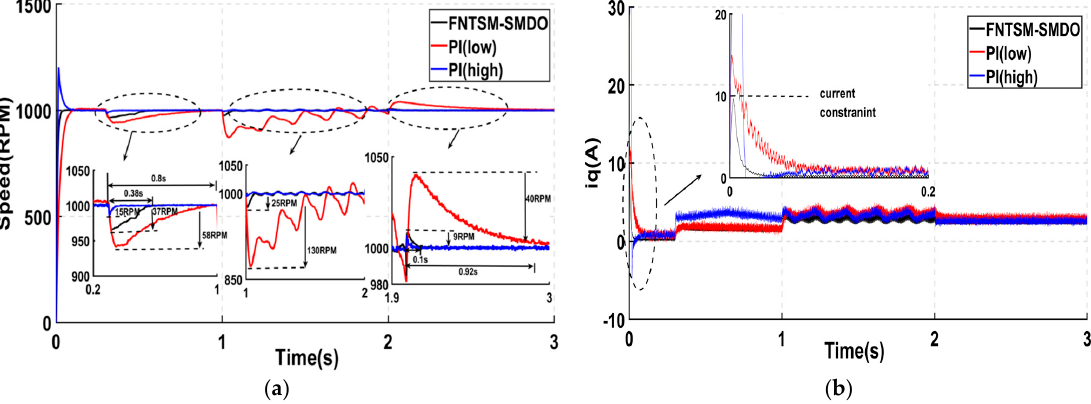
Figure 5. ( a ) Speed curve during variable–acceleration start, ( b ) Variable–acceleration start–process q -axis current curve.